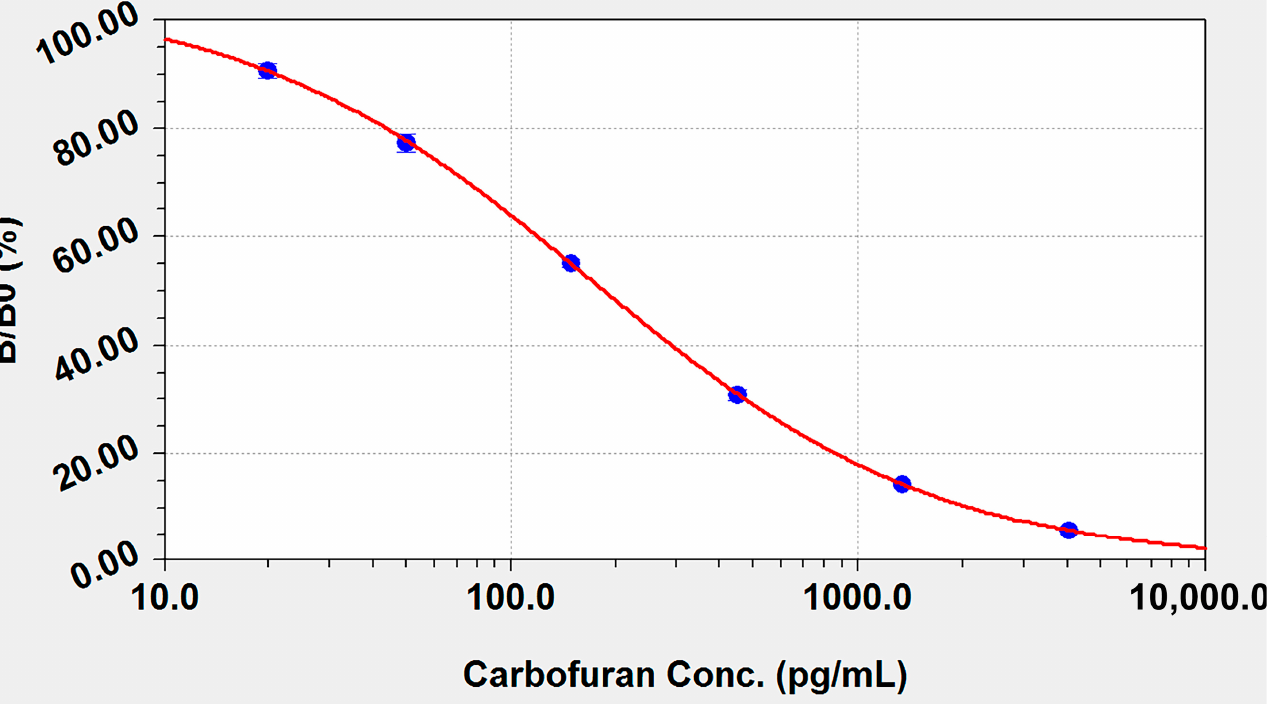
Figure 4. Standard curve for the determination of carbofuran by ELISA; the abscissa is the logarithm of the carbofuran concentration (pg/mL) and the ordinate is the inhibition rate.